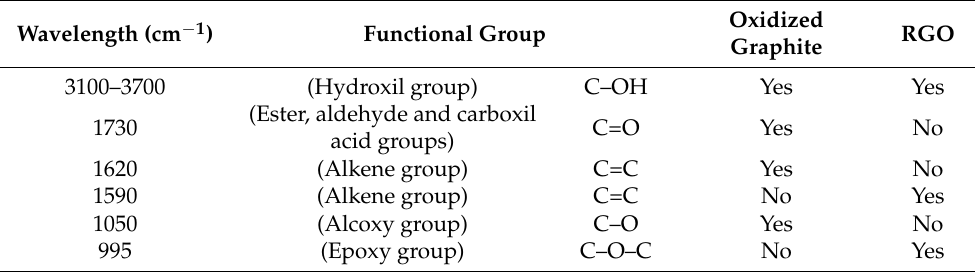
Table 2. Characteristic FTIR absorption bands of oxidized graphite and reduced graphene oxide (RGO).